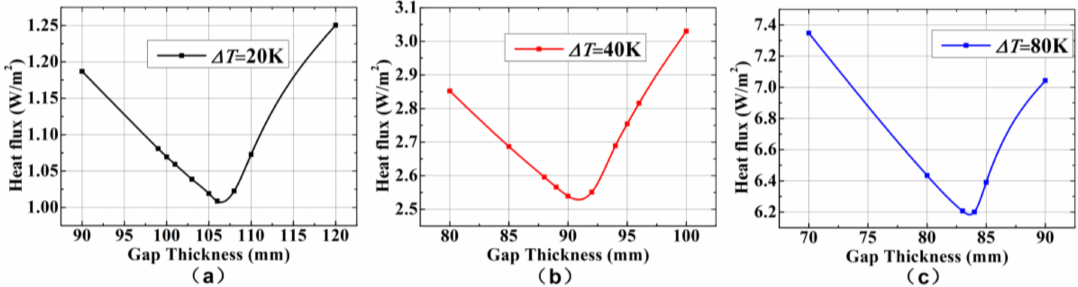
Figure 5. Variation in heat flux with horizontal enclosure gap thickness near critical enclosure thickness: ( a ) ∆ T = 20 K; ( b ) ∆ T = 40 K; ( c ) ∆ T = 80